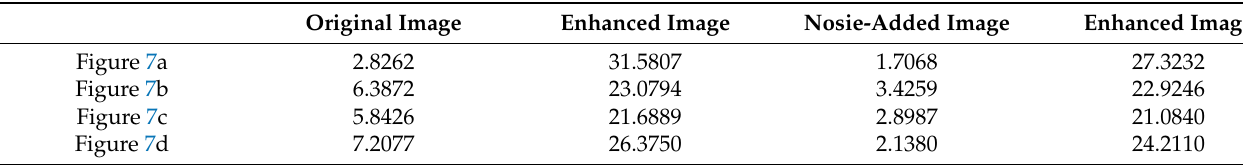
Table 3. Average SCR of the images in Figure